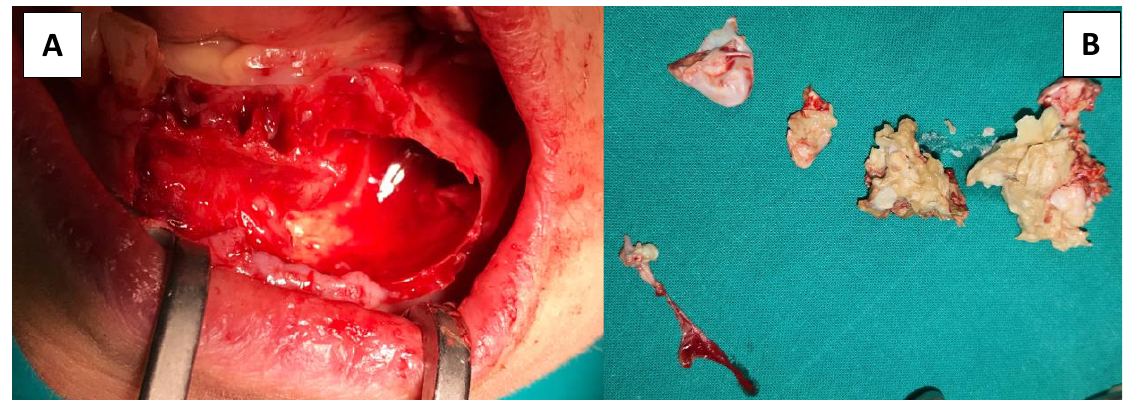
Figure 7. ( A ) Complete enucleation exposing the healthy bone perimeter. ( B ) Cystic capsule and its content later to be submitted for histologic evaluation.